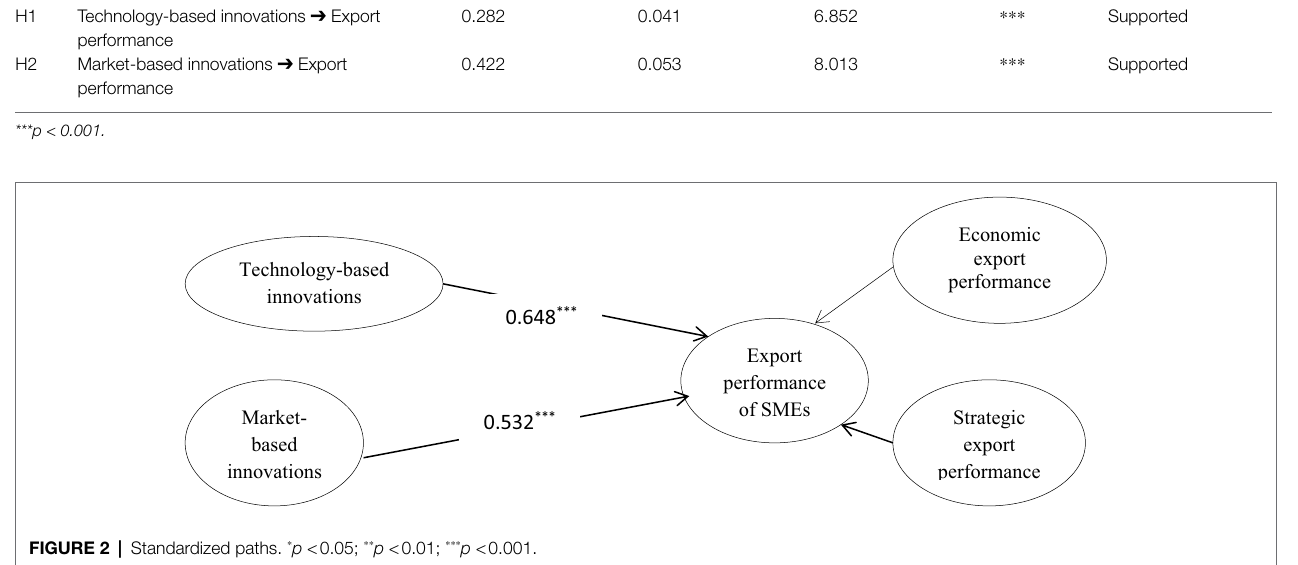
FIGURE 2 | Standardized paths. * p < 0.05; ** p < 0.01; *** p < 0.001.